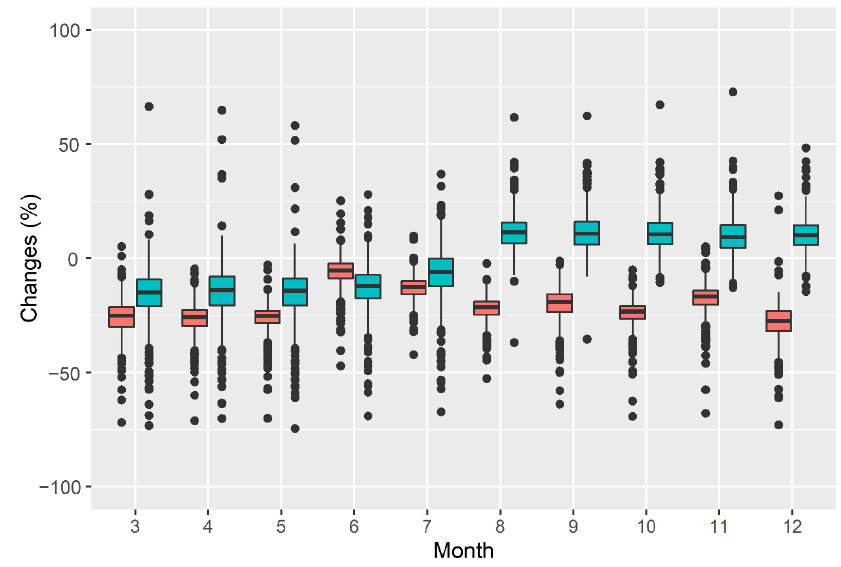
Figure 2. Monthly changes in the population mobility and restaurant sales.